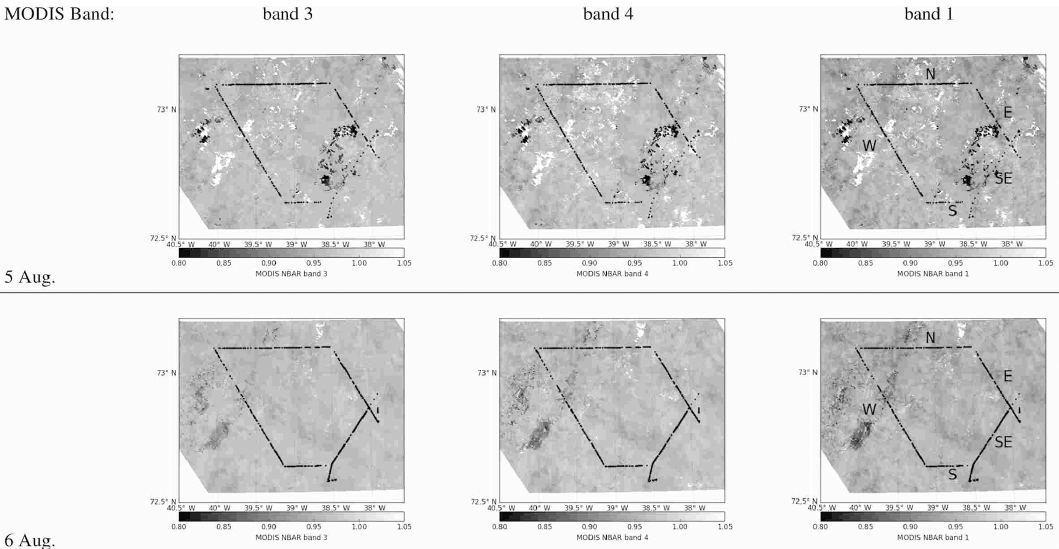
Figure 2. MODIS blue (band 3), green (band 4), and red (band 1) NBARs for 5 August (upper row) and 6 August (lower row) 2010. The black dots represent UAS data which were recorded during stable flight conditions. White areas indicate missing data.